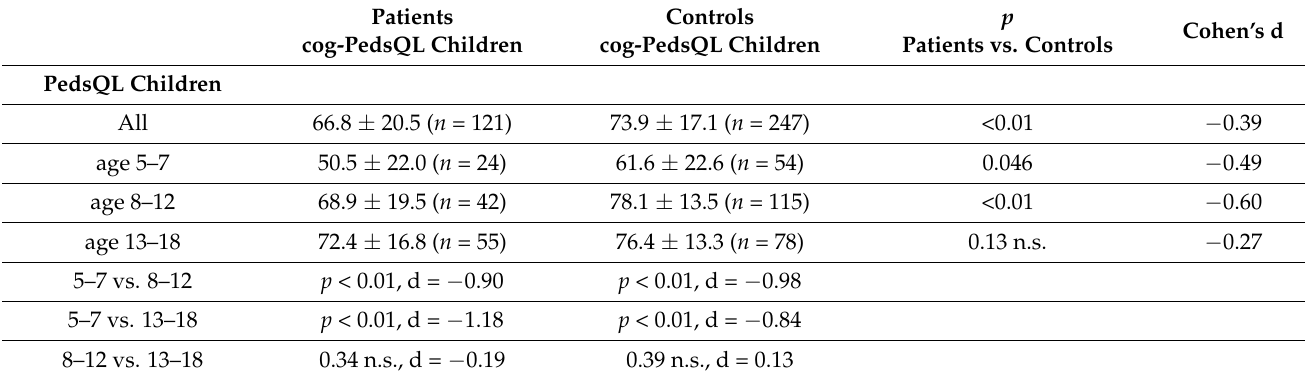
Table 4. Results of PedsQL cognitive functioning module in transplanted children and healthy